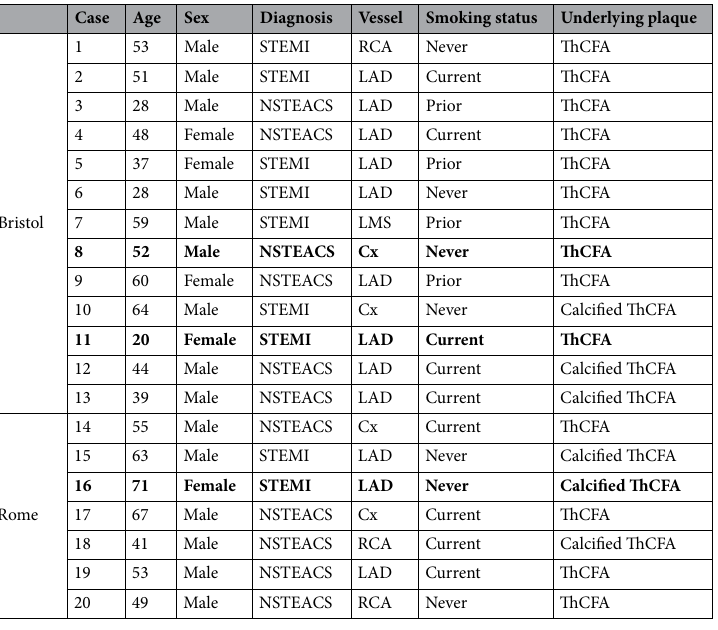
Table 1. Patient demographics. Cases in bold were excluded due to image quality during geometry reconstruction as described below. STEMI ST-elevated myocardial infarction, NSTEACS non-ST elevated acute coronary syndrome, RCA right coronary artery, LAD left anterior descending artery, Cx circumflex artery, LMS left main stem coronary artery, ThCFA thin capped